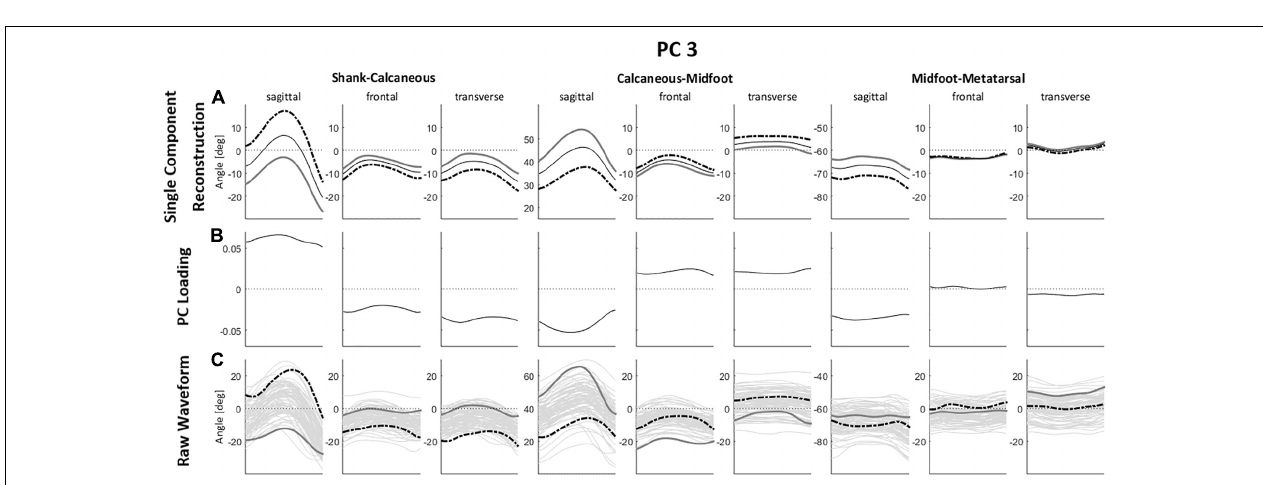
FIGURE 4 | (A) Single component reconstruction representing only the variance due to PC3 for the 5th (gray solid lines) and 95th (black dashed lines) percentile extreme representatives, and the mean reconstructed waveform (thin black solid lines); (B) PC loading vector with the pattern of variance captured by PC3; (C) raw waveforms for the 5th (gray solid lines) and 95th (black dashed lines percentile extreme representatives for PC3, superimposed on all raw waveforms (thin gray solid lines). Positive (+) and negative (–) joint angles represent the following – sagittal plane: (+) dorsiflexion, (–) plantar flexion; frontal plane: (+) eversion, (–) inversion; transverse plane: (+) abduction, (–)